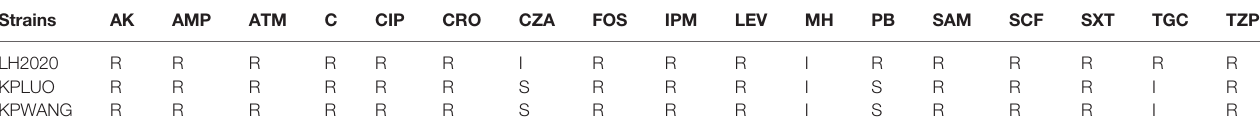
TABLE 1 | Resistant pattern of XDR/PDR K. pneumoniae clinical isolates.